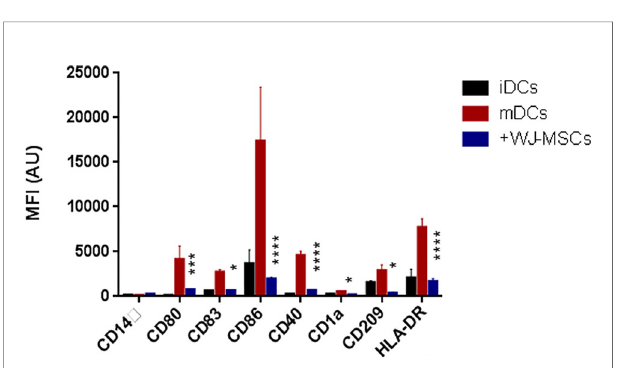
FIGURE 2 | Phenotype of DCs. Mean fl uorescence intensity (MFI) ± SD for the surface intensity of co-stimulatory molecules and maturation markers on iDCs (black), GAD65 pulsed mDCs (red), and GAD65 pulsed mDCs co-cultured with primed WJ-MSCs (blue). Data were calculated from three different experiments for each patient. Experiments performed in triplicate for each patient. DCs from fi ve patients were used. Statistical signi fi cance was tested using a two-way ANOVA with Tukey ’ s post hoc for multiple comparisons. In all analyses *p < 0.05, ***p < 0.001 and ****p <